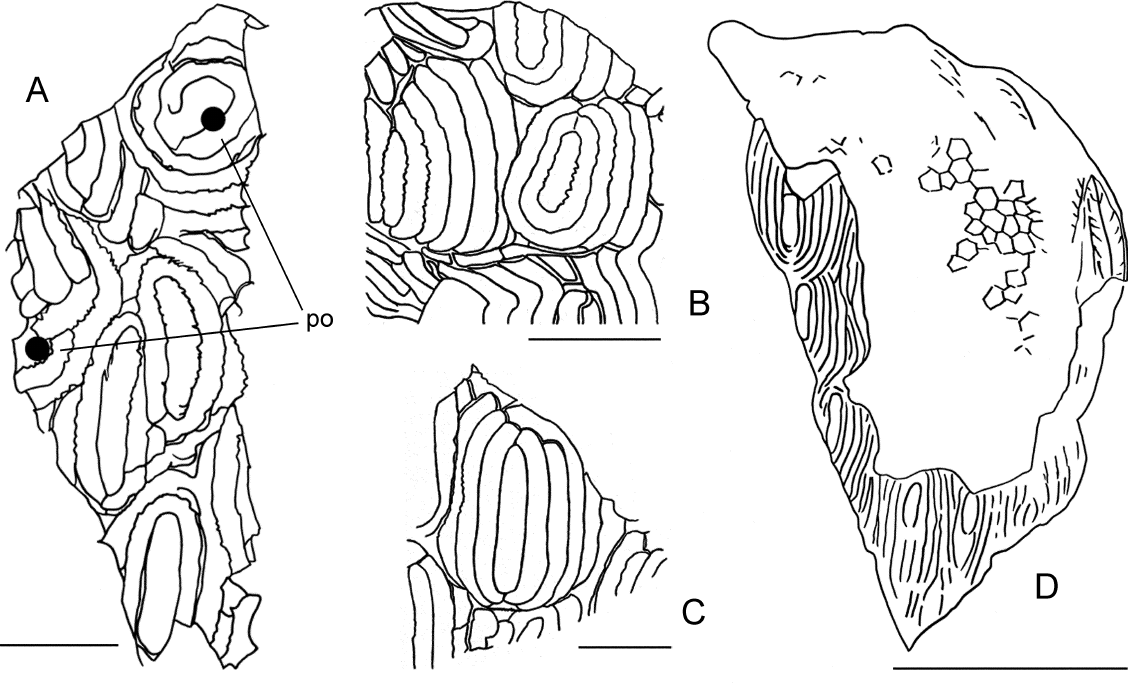
Fig. 9. A–C , Cyathaspis ? alexanderi sp. nov.: shield fragments: A, GIT 408-46; B, GIT 408-45; C, GIT 408-43; D , Tolypelepis sp. ind.: shield in visceral view, GIT 721-5. Scale bars = 1 mm (A–C); 5 mm (D). Locations : A, C, locality 85-042; B, locality 85-146-5D, Tabuska (Vishnevaya Gora) section, the Central Urals, Tabuska Beds either of the lower P ř idoli level (Shujskij 1981; Shurygina et al. 1981) or upper Ludlow (Modzalevskaya & Märss 1991); D, locality 8825-11/15a, Right Anuchin River, Cape Vize, north of Northern Island, Novaya Zemlya Archipelago; uppermost part of the Konstantinovskaya Formation, P ř idoli, upper Silurian. Abbreviation : po, pores of lateral line canals (pores shown larger than they are in